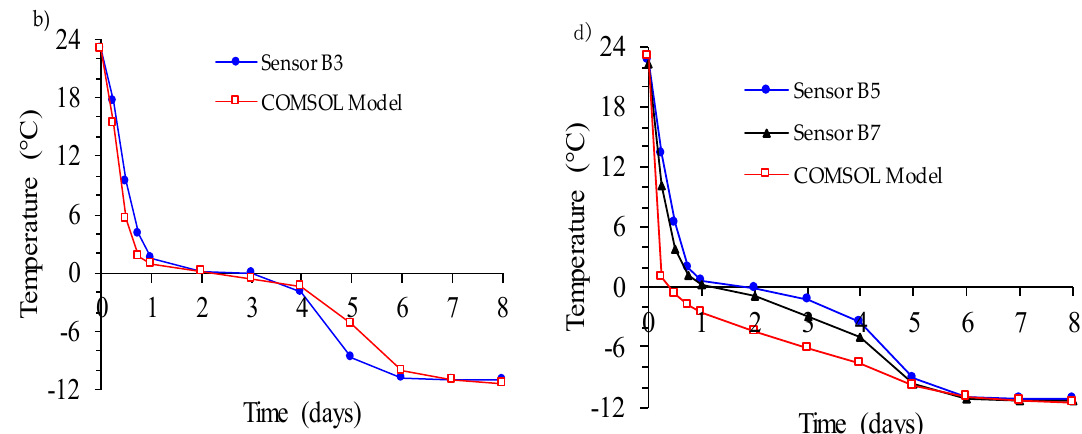
Figure 7. Model validation: comparisons between simulation and laboratory results for temperature evolution with time in the barrel: ( a ) sensor B1, ( b ) sensor B3, ( c ) sensors B4 and B6, and ( d ) sensors B5 and B7.